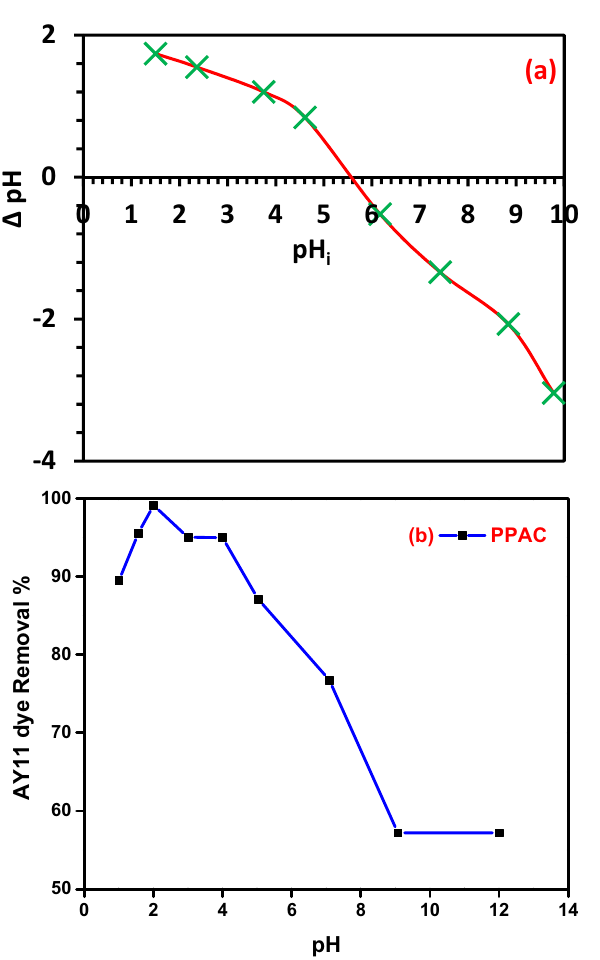
Figure 6. ( a ) pH PZC of the PPAC prepared at 800 °C, ( b ) AY11 dye removal percentage by PPAC at different pH value; AY11 dye (100 mg/L), PPAC dose (1.0 g/L), Temp. (25